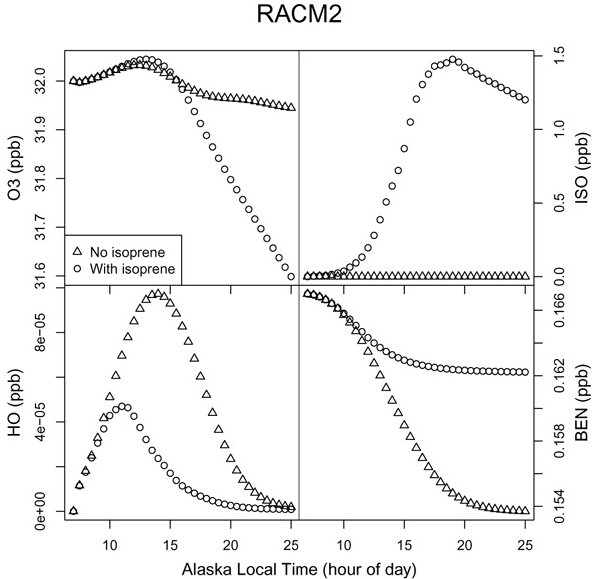
Fig. 7. Results from running a photochemical box model (RACM2) with (circles) and without (triangles) isoprene emissions. The model was driven with the isoprene emissions observed on day of year 180 during EC05. The model time domain reached day 01:00LT on day of year 181, which is displayed as hour 25. Species codes: O3 is ozone (O 3 ) , HO is the hydroxyl radical, ISO is isoprene and BEN is benzene (C 6 H 6 ) . Note that solar noon occurs around